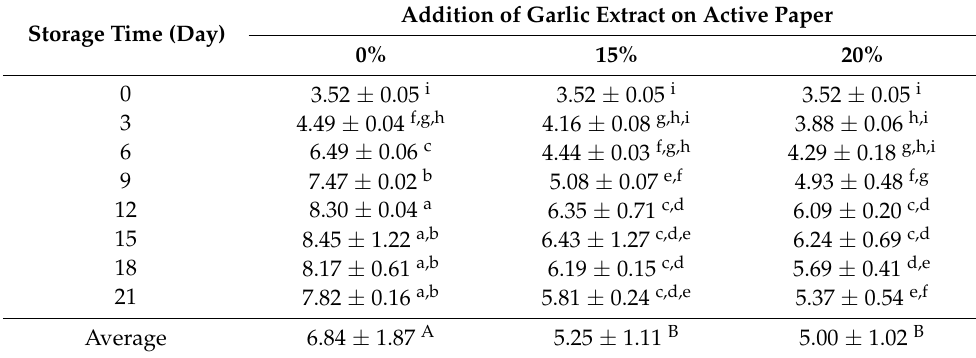
Table 3. The TPC value of packaged meat samples stored in cold storage for 21 days. Storage Time